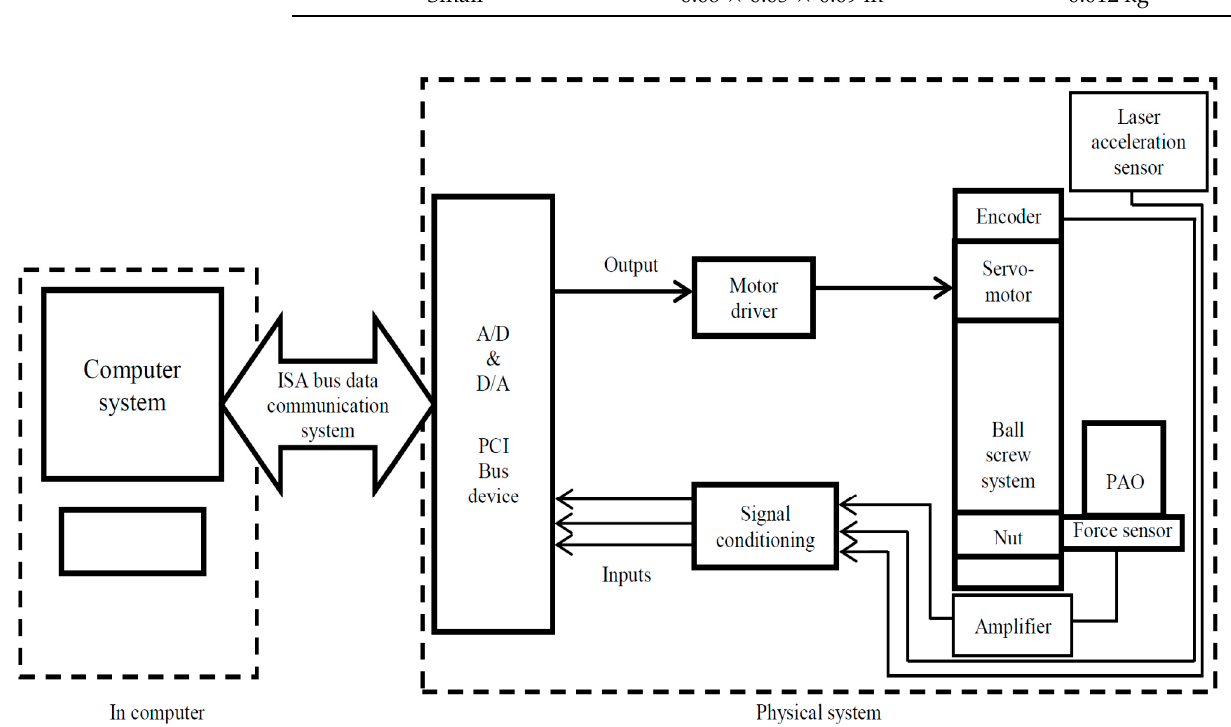
Figure 3. The experimental setup and the communication channels for the power assist robotic system for lifting objects. A laser-type acceleration sensor is set over the PAO, as the figure shows.